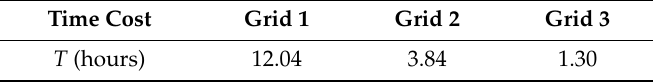
Table 5. The time cost for the unsteady cavitation simulation.